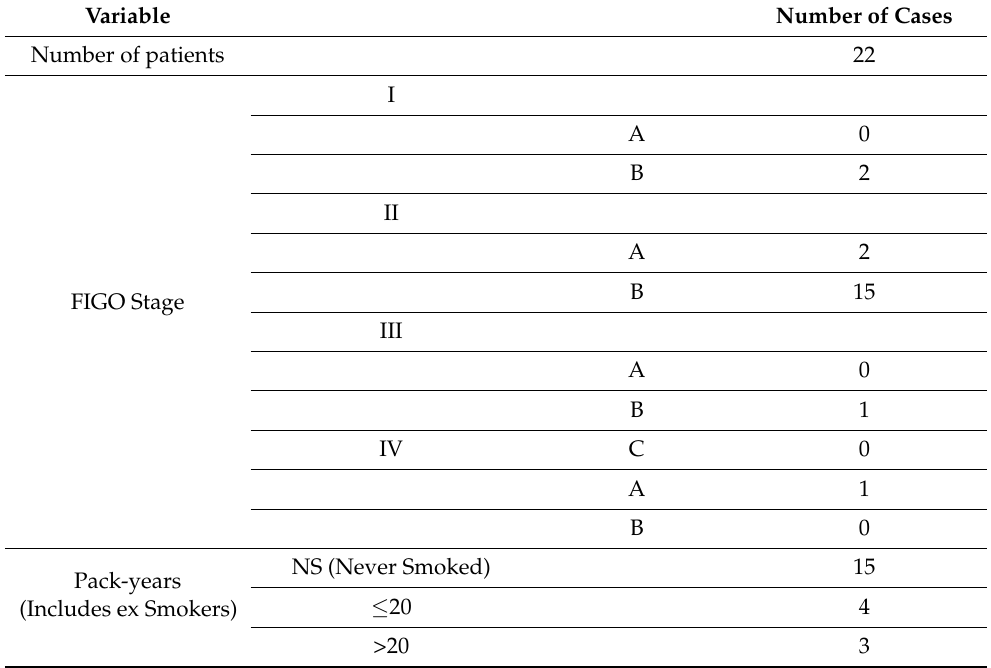
Table 3. Patient characteristics for the